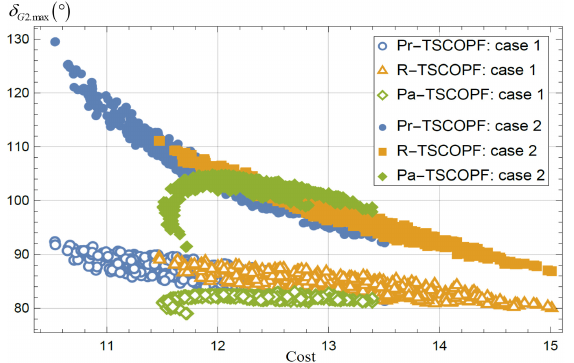
Figure 9. Control objective versus maximum rotor angle δ G2.max of the parametric TSCOPF and normal OPF under 500 random realization of the uncertain parameters in the 3-machine, 9-bus system